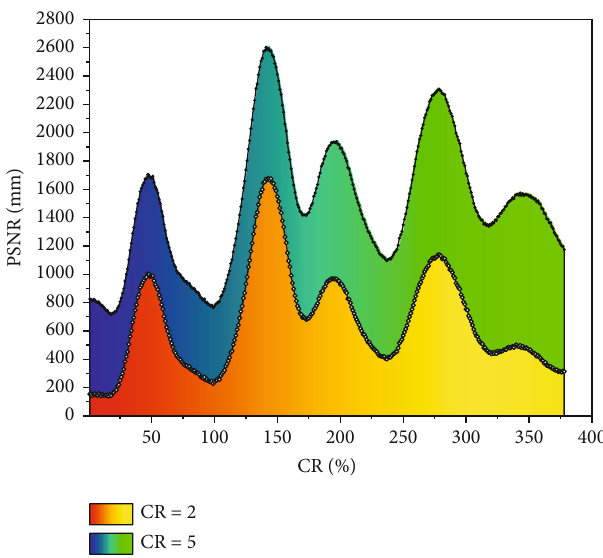
Figure 8: PSNR values for di ff erent chaotic